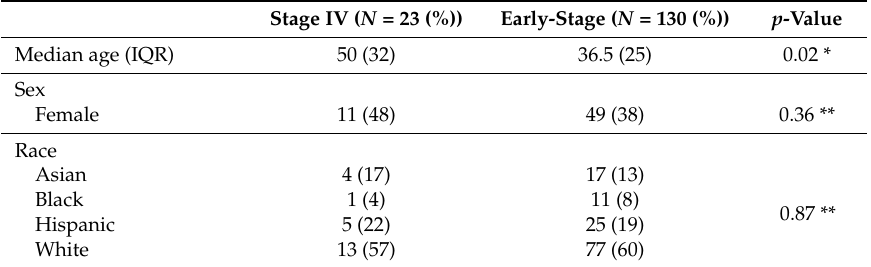
Table 2. Characteristics of patients with stage IV and early-stage synovial